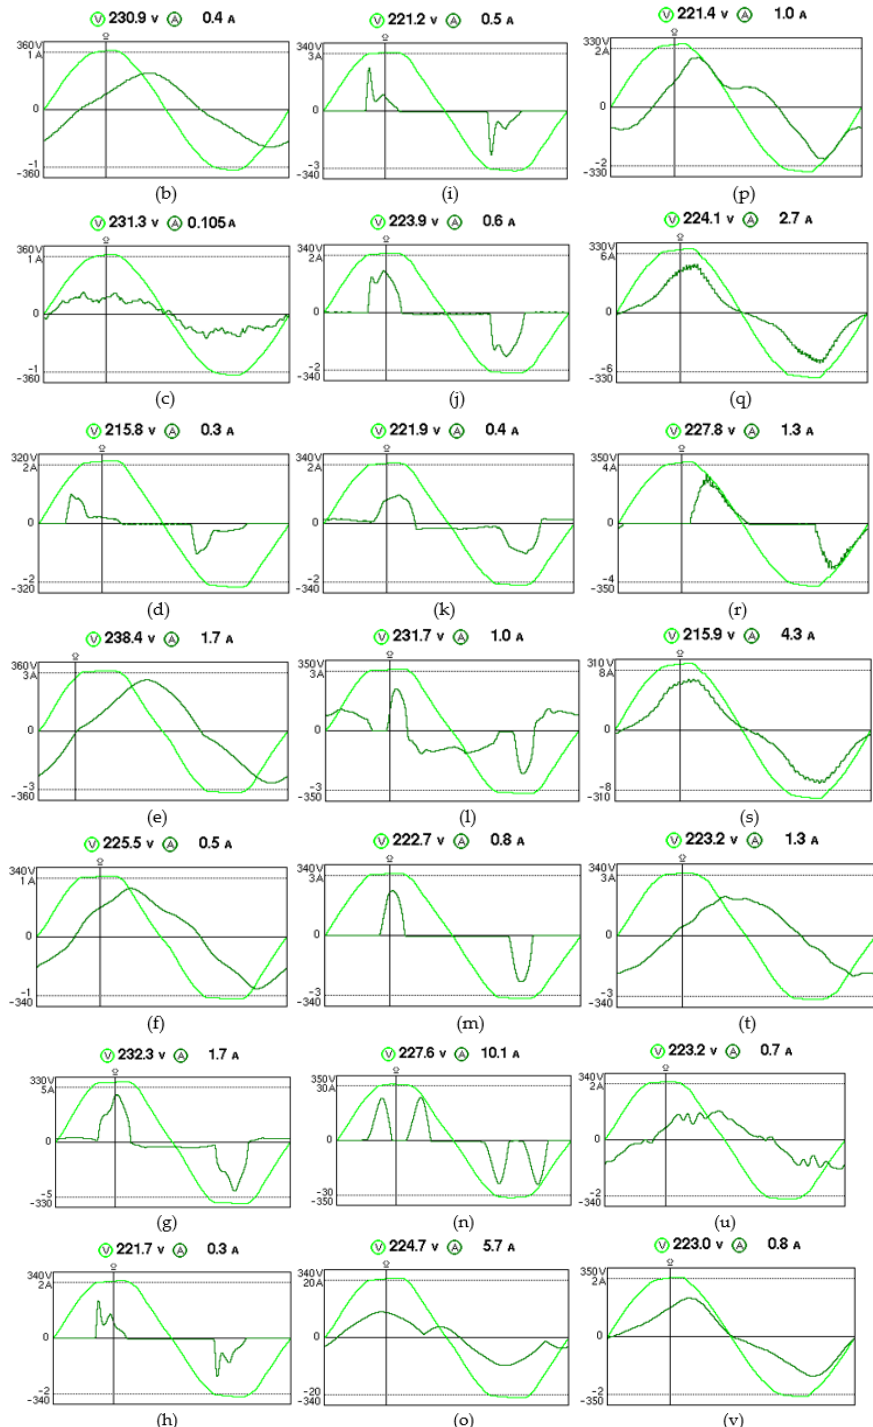
Figure 18. ( a ). Electrical measurements, voltages, and currents, in power substations. Electrical measurements, voltages, and currents, from different nonlinear consumers used in residential and educational buildings: ( b ) Classical fluorescent lamp; ( c ) Classical fluorescent lamp with capacitor; ( d ) Compact fluorescent Ip; ( e ) Sodium-vapor lamp; ( f ) Refrigerator; ( g ) Air conditioning system; ( h ) Standby laptop; ( i ) Laptop—normal operation; ( j ) Desktop PC with cathode tube ray monitor; ( k ) Desktop PC with LCD monitor; ( l ) Laser printer; ( m ) Electric drive single-phase using static converter; ( n ) Induction furnace medium frequency converter (measurement on one phase); ( o ) Microwave oven; ( p ) Portable grinder machine; ( q ) Portable finishing machine; ( r ) Portable high-speed milling machine; ( s ) Angular high-speed grinder machine; ( t ) Three-phase induction motor (measurement on one phase); ( u ) Three-phase induction motor with capacitor (measurement on one phase); ( v ) Single-phase induction motor using triac variator.